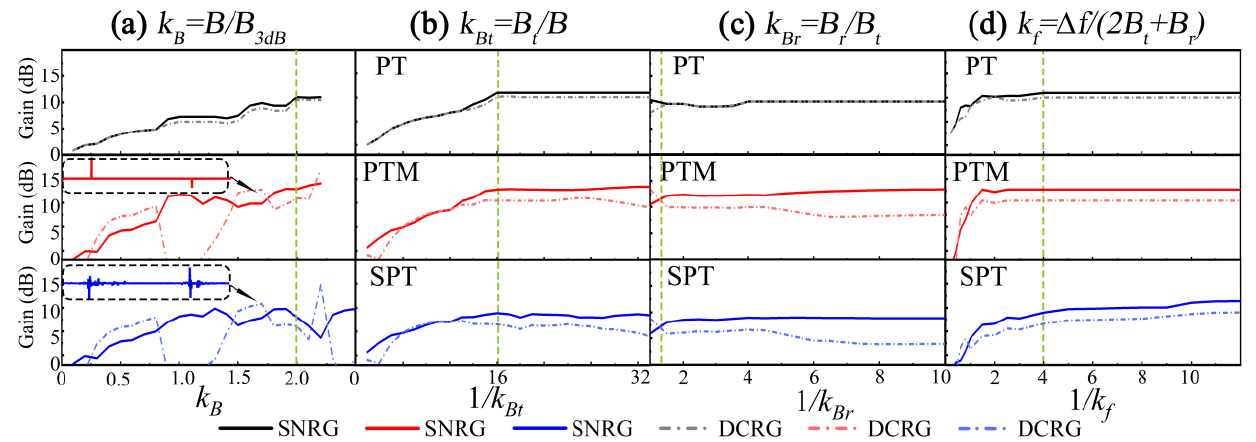
Figure 9. Effects of filter parameters: ( a ) B f , ( b ) B t , ( c ) ∆ f and ( d ) B r on SNRG and DCRG of the synthesized UGW signals processed by FBR-RC-SSP.